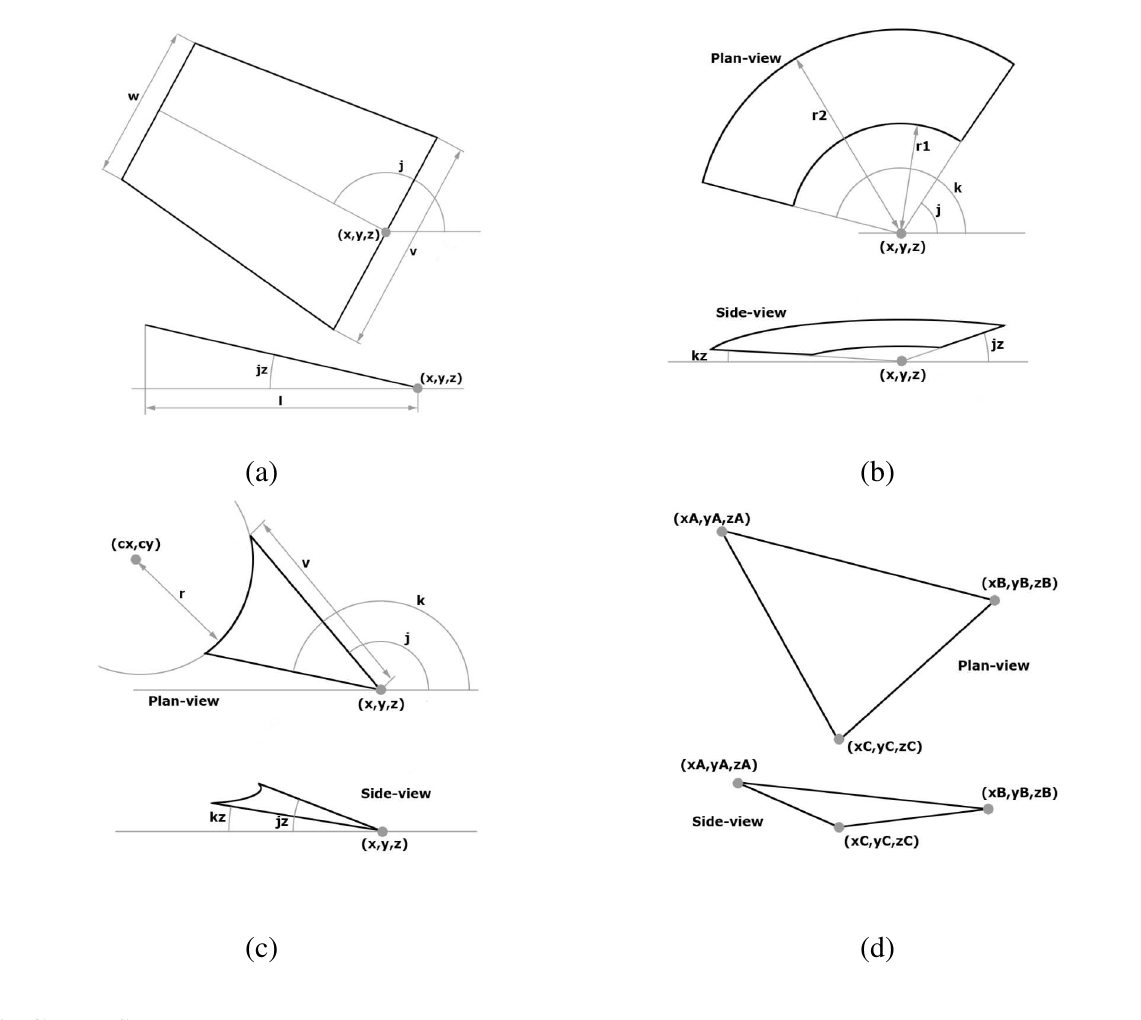
Figure 4. EEmap road figures with